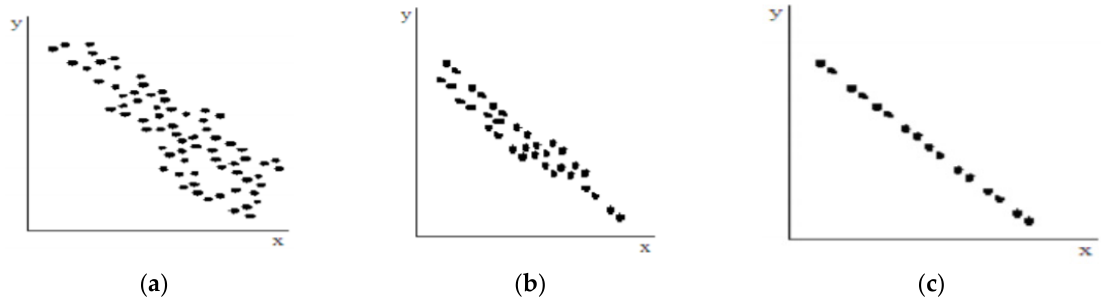
Figure 2. The negative correlation of an ( a ) inversely proportional correlation, ( b ) strong inversely proportional correlation, and ( c ) completely inversely correlation. Table 1. Correlation values and its relation